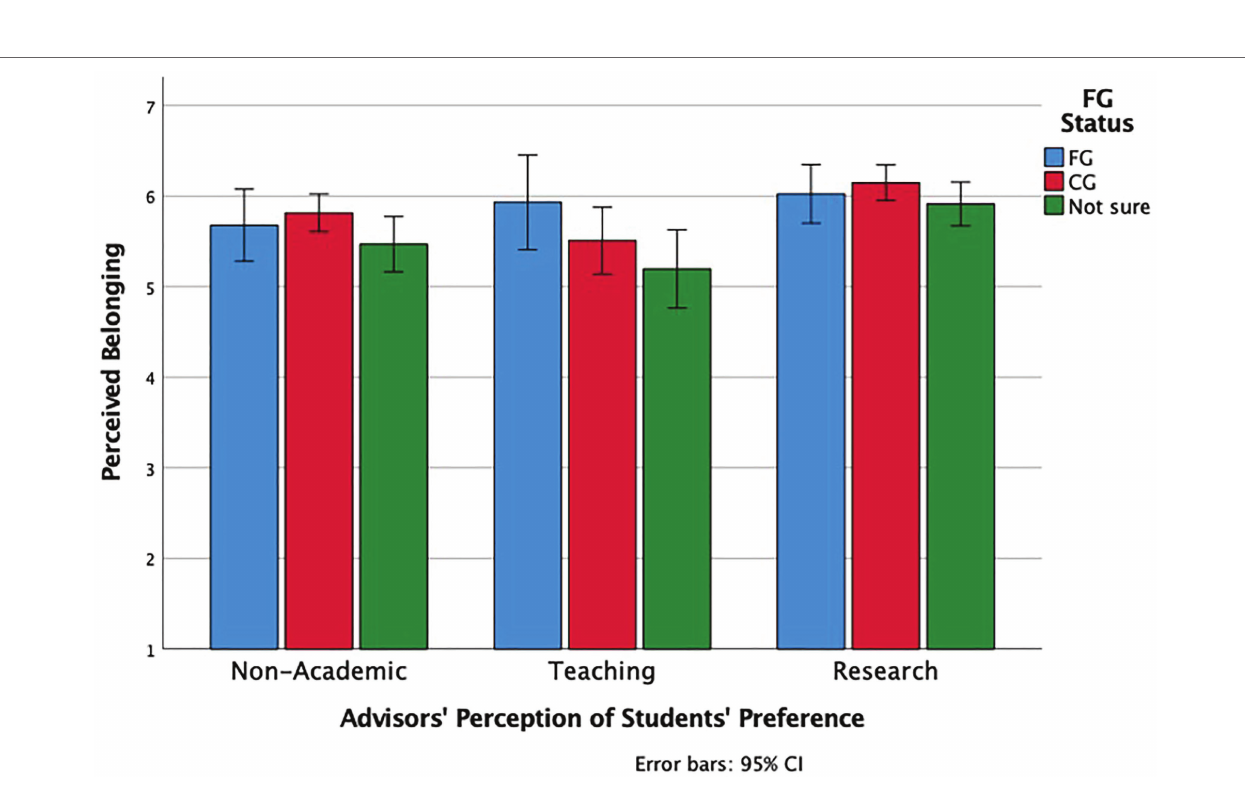
FIGURE 7 | Advisors’ perceived belonging of their students, as a function of first-generation (FG) status and their perception of students’ career